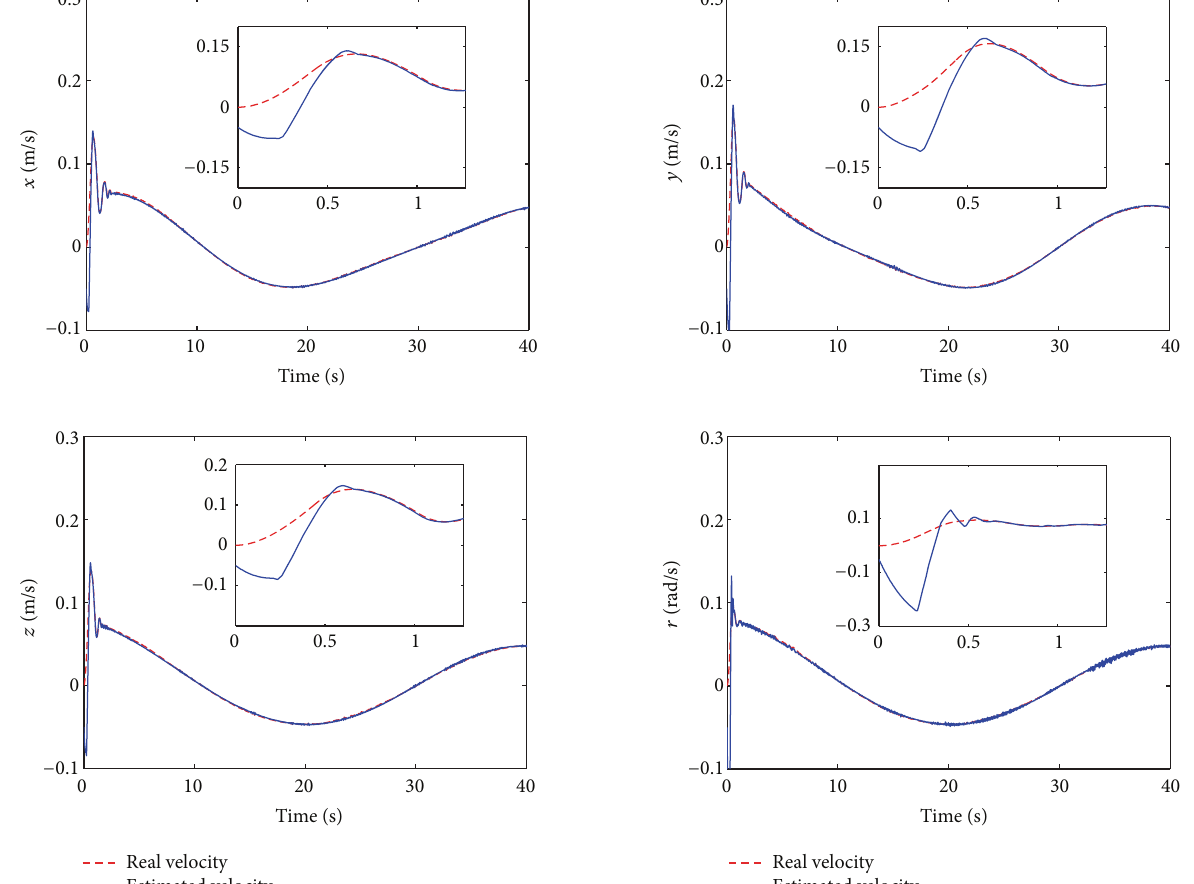
Figure 5: Estimated velocity and real velocity of output feedback